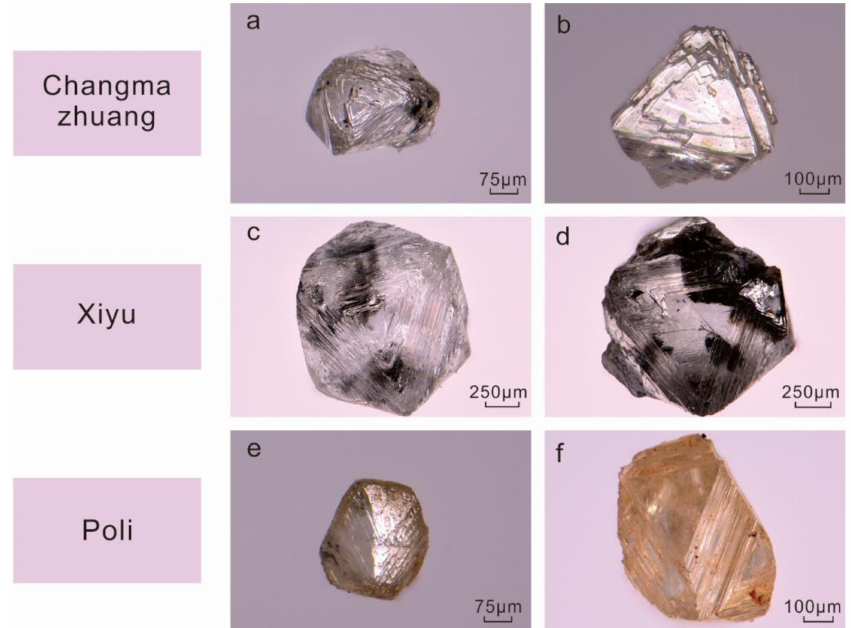
Figure 6. Pre-kimberlite surface textures of diamonds from three belts in Mengyin deposit. ( a ) Sam- ples SL1-2 and ( b ) SL-7 from the Changmazhaung belt showing serrate laminae; ( c ) samples HQ23-13 and ( d ) HQ23-15 from the Xiyu belt showing triangular laminae; ( e ) samples Q29-3 and ( f ) Q29-7 from the Poli belt showing ribbed